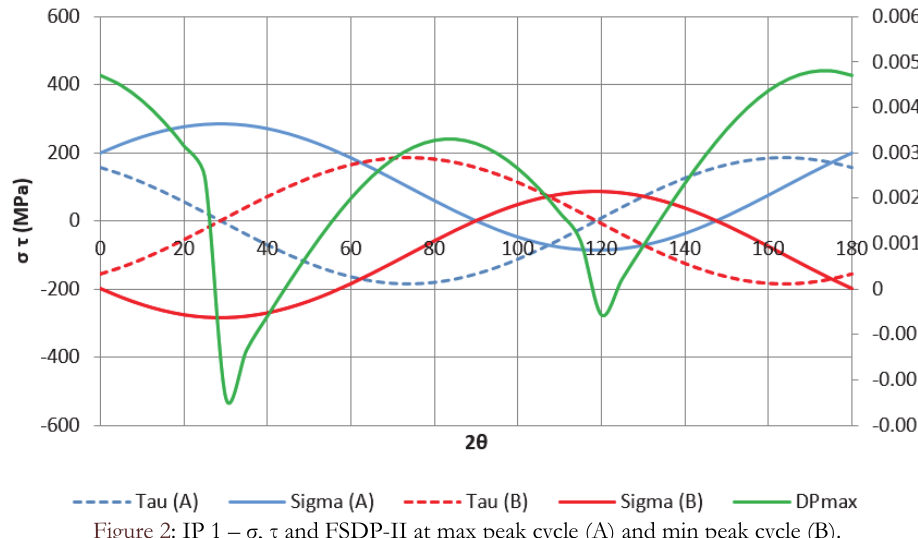
Figure 2: IP 1 – σ , τ and FSDP-II at max peak cycle (A) and min peak cycle (B).